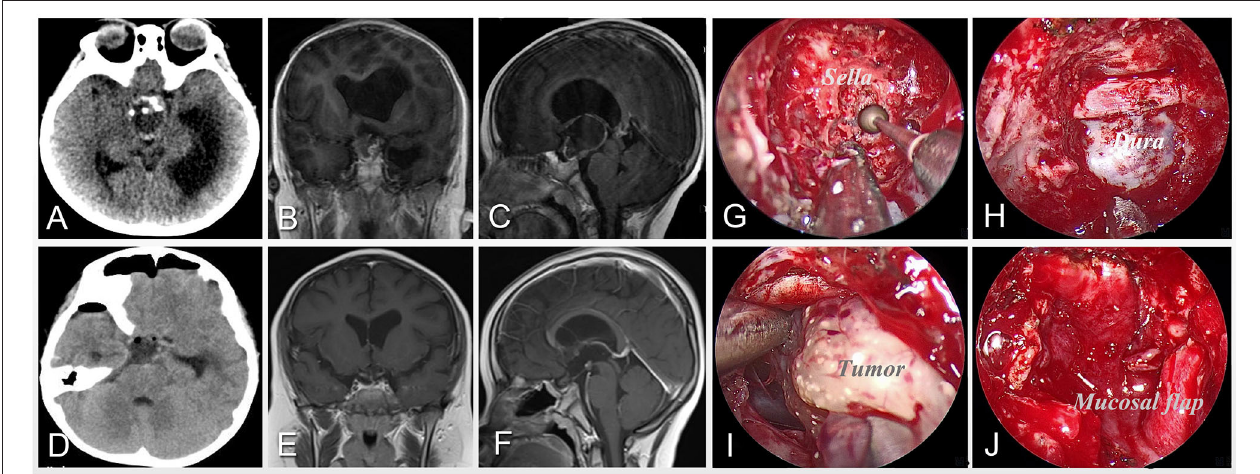
FIGURE 1 | Case 5 was an 8-year-old boy who presented with developmental retardation and headache before surgery. Preoperative imaging of CT (A) and MRI (B,C) shows a calcified and solid-cystic lesion located in the suprasellar region and invading the third ventricle with obstructive hydrocephalus. After careful preoperative evaluation, the extended neuroendoscopic endonasal approach was performed for the patient. The intraoperative pictures (G–J) illustrate the surgical procedures including drilling the sphenoid sella along the midline (G) , exposing the bone window for operation (H) , and separating the tumor along its boundary (I) , and reconstructing the skull base with pedicled mucosal flap after resection (J) . Postoperative imaging of CT (D) and MRI (E,F) demonstrates the gross-total resection of the